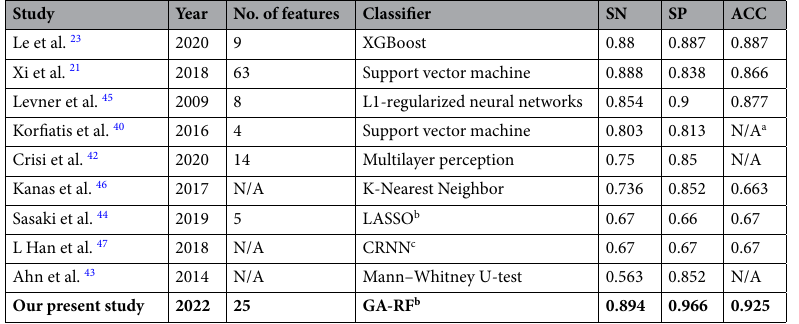
Table 3. Comparisons between our models and other previous predictors of the MGMT methylation status in glioblastoma multiforme. SN, sensitivity; SP, specificity; ACC, accuracy. a “N/A” means that the information was not shown in the research. b LASSO, least absolute shrinkage and selection operator; GA-RF, genetic algorithm-random forest. Bold font indicates the results of this study. c Bi-directional convolutional recurrent neural network